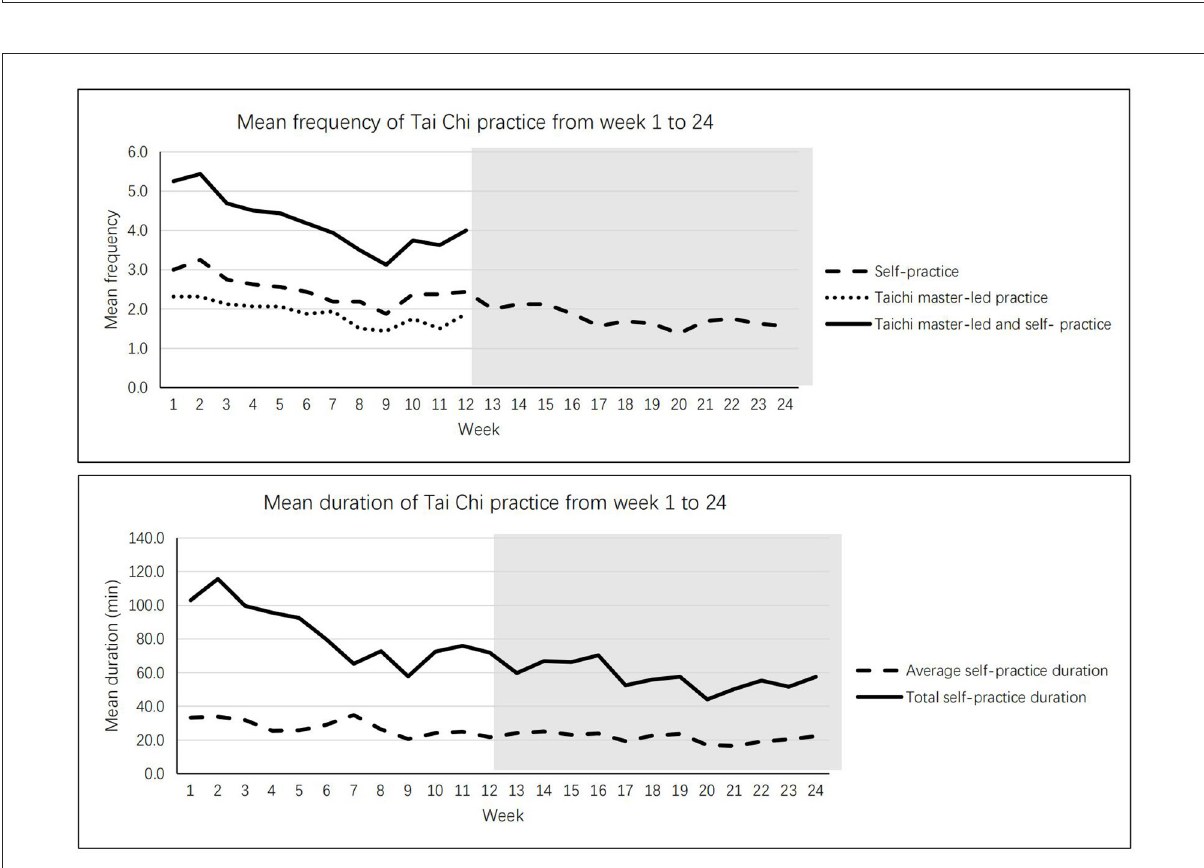
FIGURE3 Maintenance of Tai Chi practice from week 1 to week